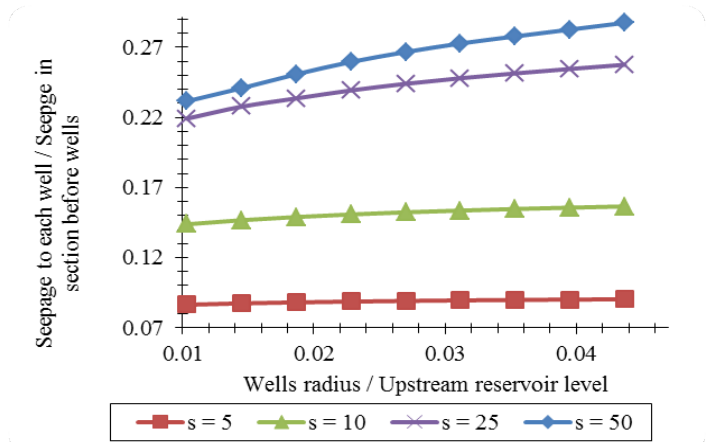
Fig. 4. Effect of wells radius on inlet seepage to each well (upstream reservoir level is 12 m).